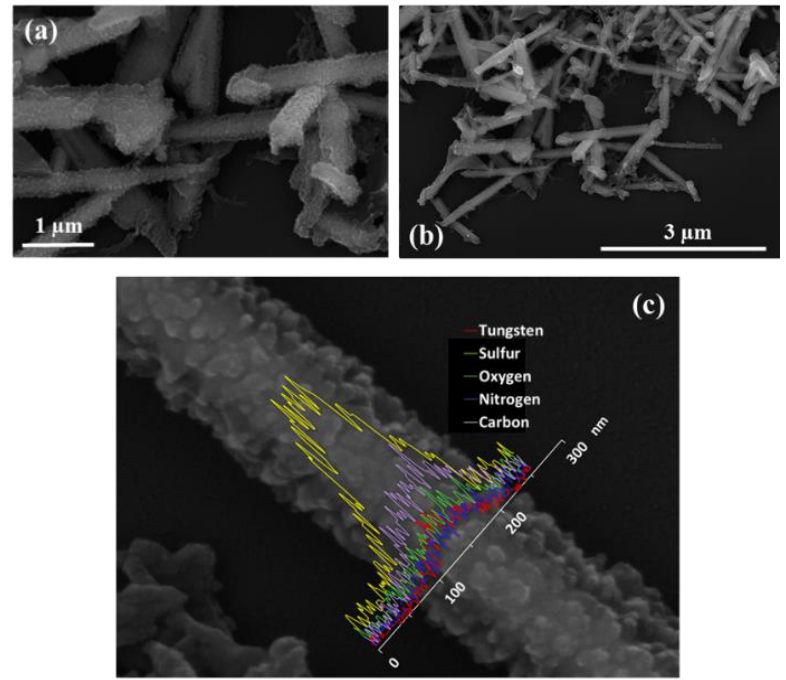
Figure 4. HRSEM images ( a , b ) and EDS line scan ( c ) of sample INT-PANI-HA.